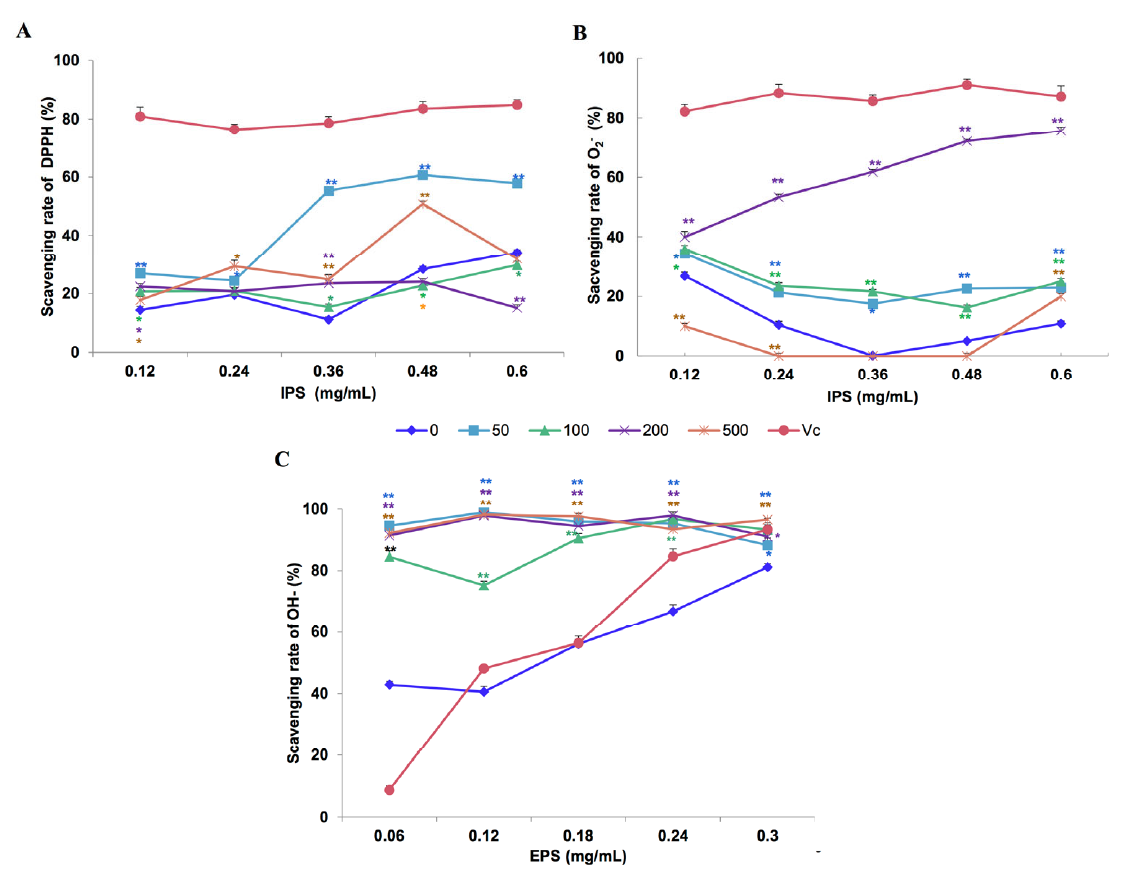
Figure 5. In vitro scavenging effects of intracellular polysaccharide (IPS; ( A , B )) and extracellular polysaccharide (EPS; ( C )) from Lentinula edodes 808 (ACCC 52357) for DPPH ( A ), O 2 − ( B ), and –OH ( C ) radicals. Polysaccharides were extracted from liquid static cultures with different Fe 2+ concentrations (0, 50, 100, 200, and 500 mg/L) added at the appropriate inoculation time and incubated under static conditions at 25 ◦ C for 50 days. Data are the means of experiments in triplicate ± SD. Asterisks indicate significant differences at p < 0.01 (**) and p < 0.05 (*), according to the LSD test. Vitamin C (Vc) was assayed as a positive control. Deionized water (0) was used as a negative control. The in vitro antioxidant activities of polysaccharides produced in the L. edodes liquid cultures under optimal Fe 2+ concentration and induction time are presented in Figure